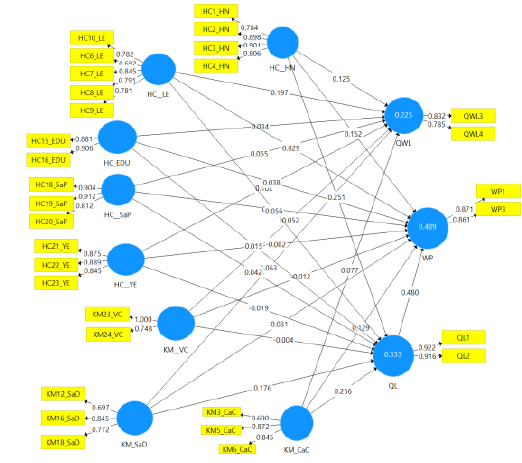
Figure 2. Assessment of First-Order